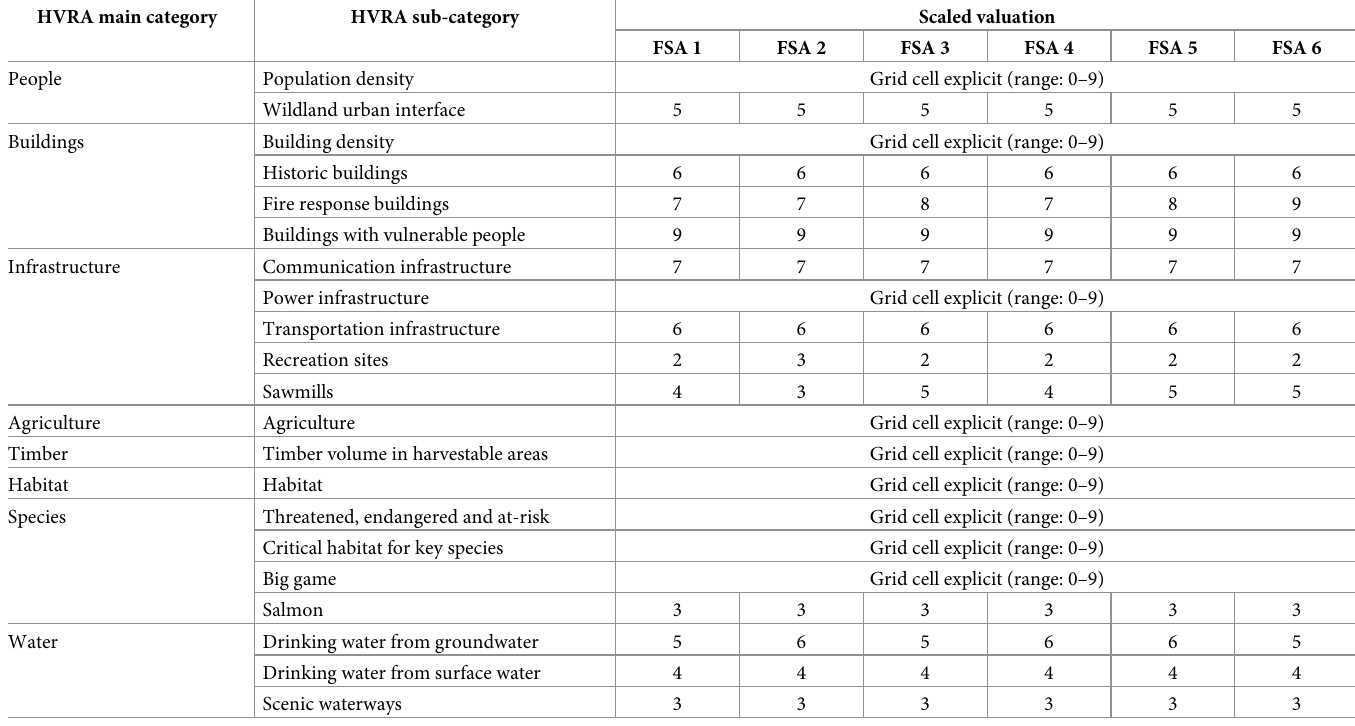
Table 1. Scaled valuations for HVRA subcategories by